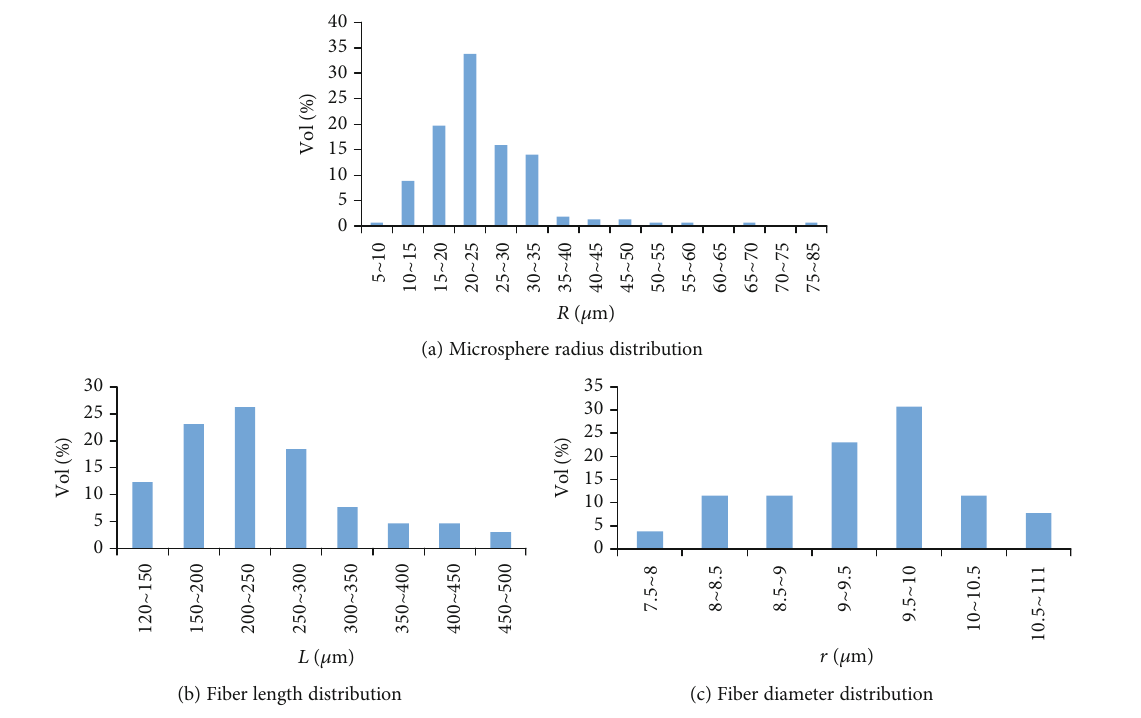
Figure 2: Statistical results of mesoscopic parameter.